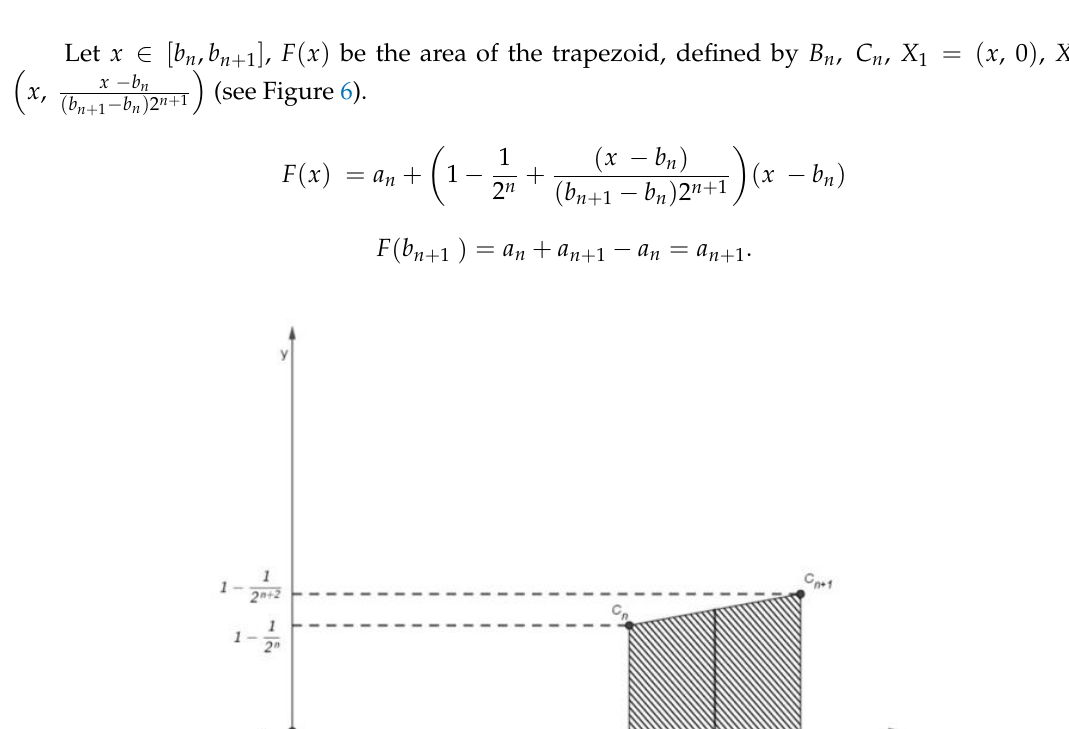
Figure 5. The area of the trapezoid defined by points C n , C n + 1 , B n , B n + 1 .